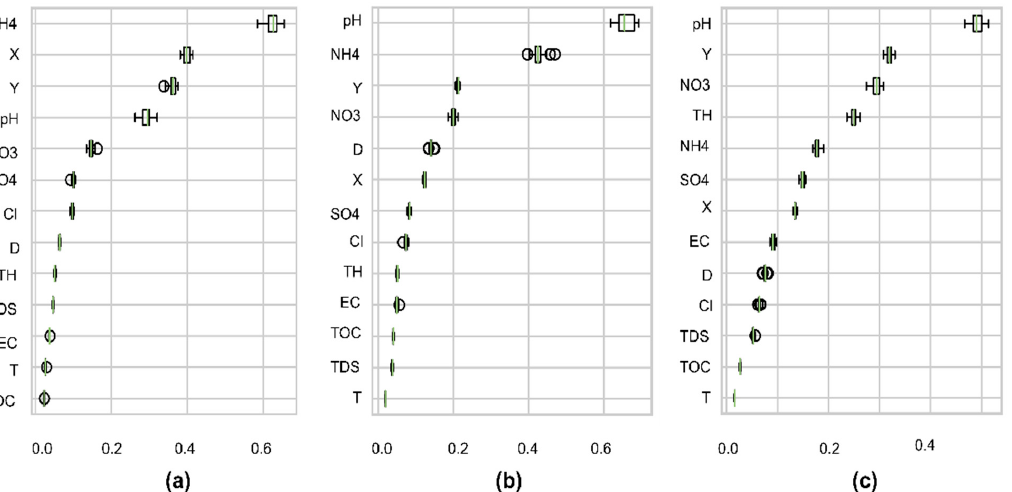
Figure 9. Permute importance distributions on training data: the vertical axis is the feature names, the horizontal axis is the prediction of score reduction when permuting that feature: ( a ) As model; ( b ) Fe model; and ( c ) Mn model.